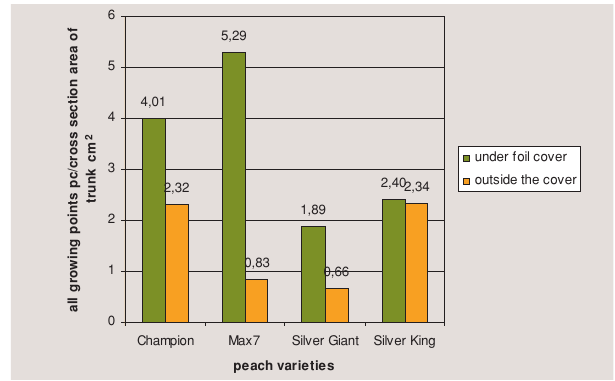
Figure 5. Specific number of growing points of peach trees grown under foil 4,015,291,892,402,320,830,662,340123456ChampionMax7SilverGiantSilverKing peachvarieties a ll g r o w i ngpo i n t s p c / c r o sssec t i on a r ea o ft r un kc m 2 underfoilcoveroutsidethecover